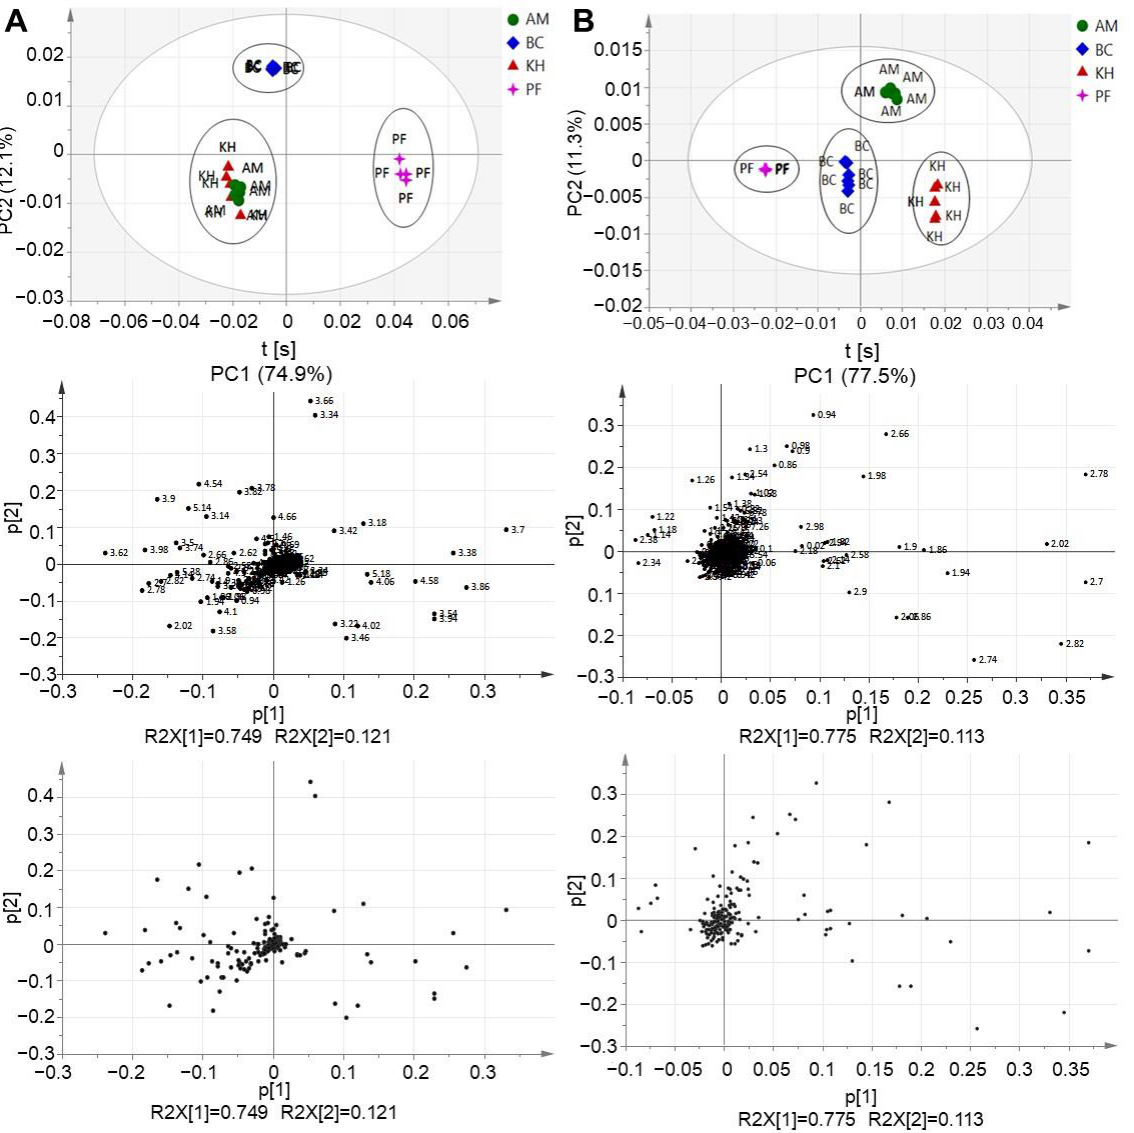
Figure 3. ( A ) Principal Component Analysis (PCA) was performed on the NMR chemical shifts and revealed a significant separation among the samples. PCA score plot of three different kiwifruits: Hayward (KH), Bidan (BC), A. Arguta (AM) and persimmon Fuyu (PF). ( B ) PCA score plot after excluding the sugar region of KH, BC, AM and PF.